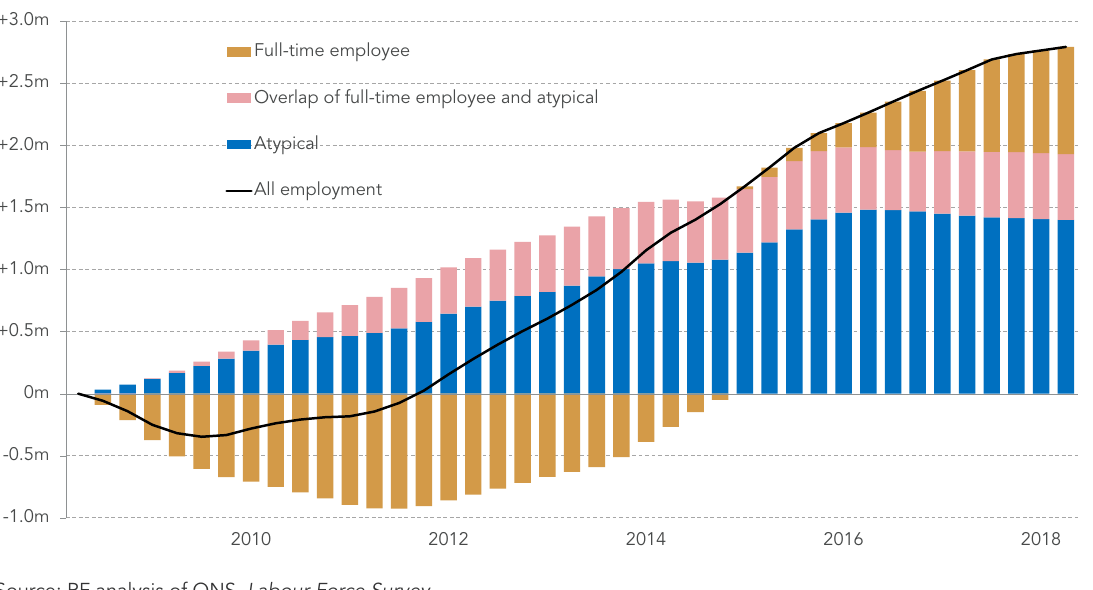
Figure 28: Atypical work has accounted for the majority of post-recession employment growth Change in employment since 2008, 16+ year